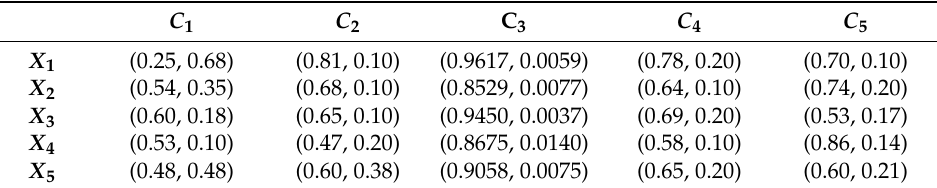
Table 9. The collective intuitionistic fuzzy decision matrix D .